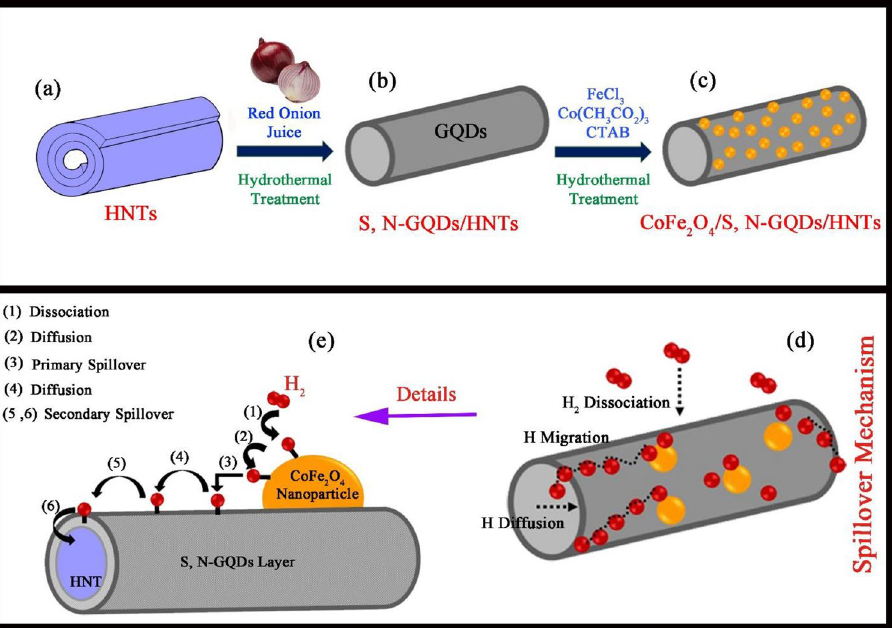
Figure 1. ( a – c ) Decoration of S, N-GQDs and CoFe 2 O 4 nanoparticles on the HNT substrate and ( d , e ) Spillover mechanism of CoFe 2 O 4 /S, N-GQDs/HNTs for hydrogen